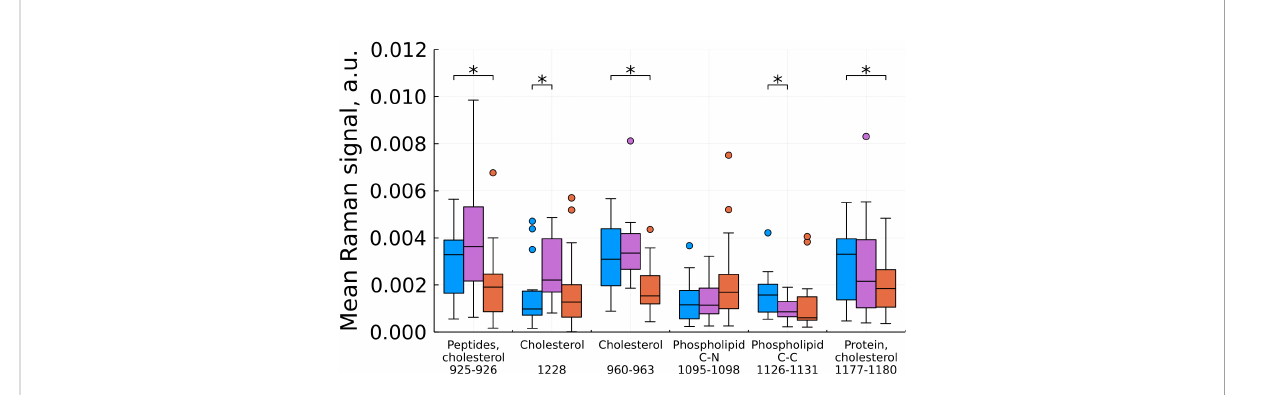
FIGURE 4 Mean Raman signal in bands of cholesterol, phospholipids and protein (blue – normal tissue, magenta - tumor edge, orange - tumor center). Numbers in horizontal labels denote the range of Raman shifts. *p<0.05.